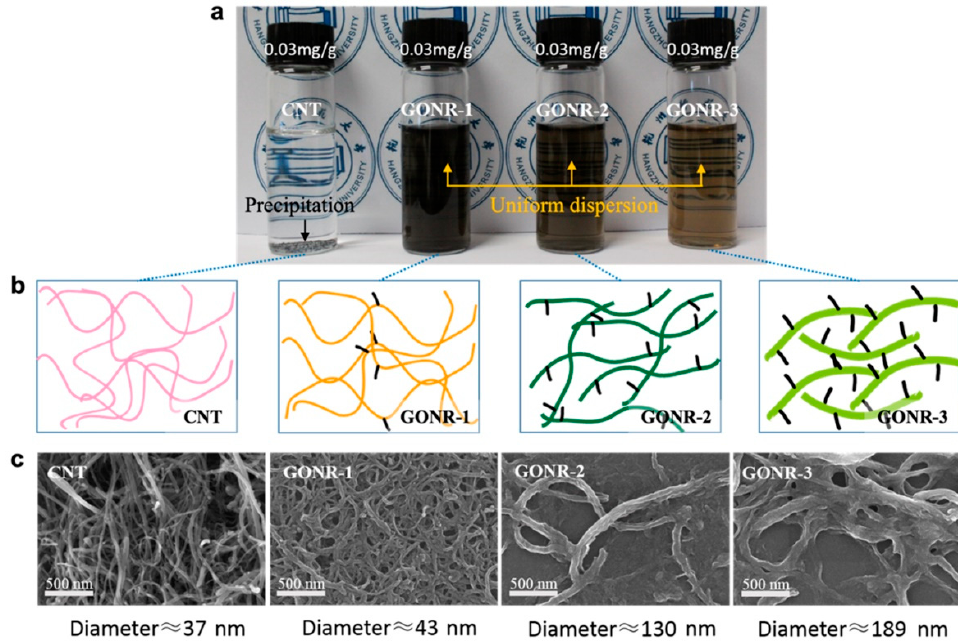
Figure 1. Dispersion and morphology of the CNT and GONRs with different oxidation degrees: ( a ) photos of dispersion of the CNT and GONRs in aqueous solution, showing different dispersion levels; ( b ) schematic illustration of the CNT and GONRs with different oxidation degrees; ( c ) SEM images of the CNT and GONRs with different morphology and structure features.